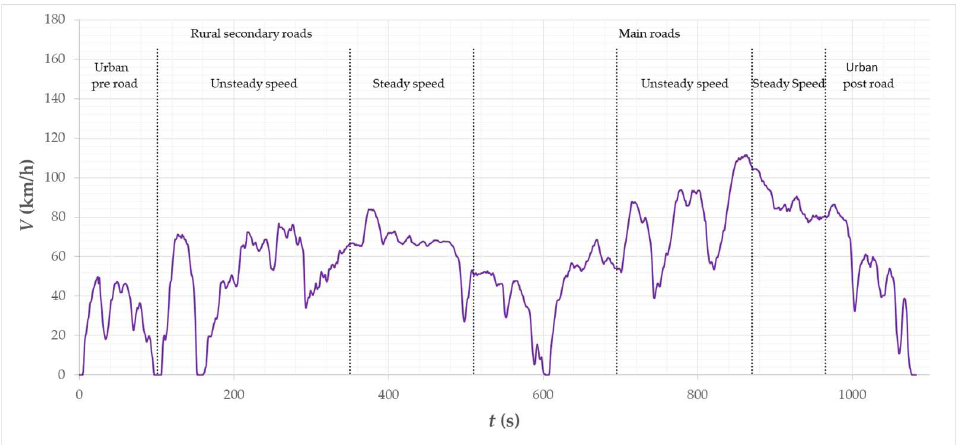
Figure 21. Vehicle speed waveform of the Artemis Road cycle .